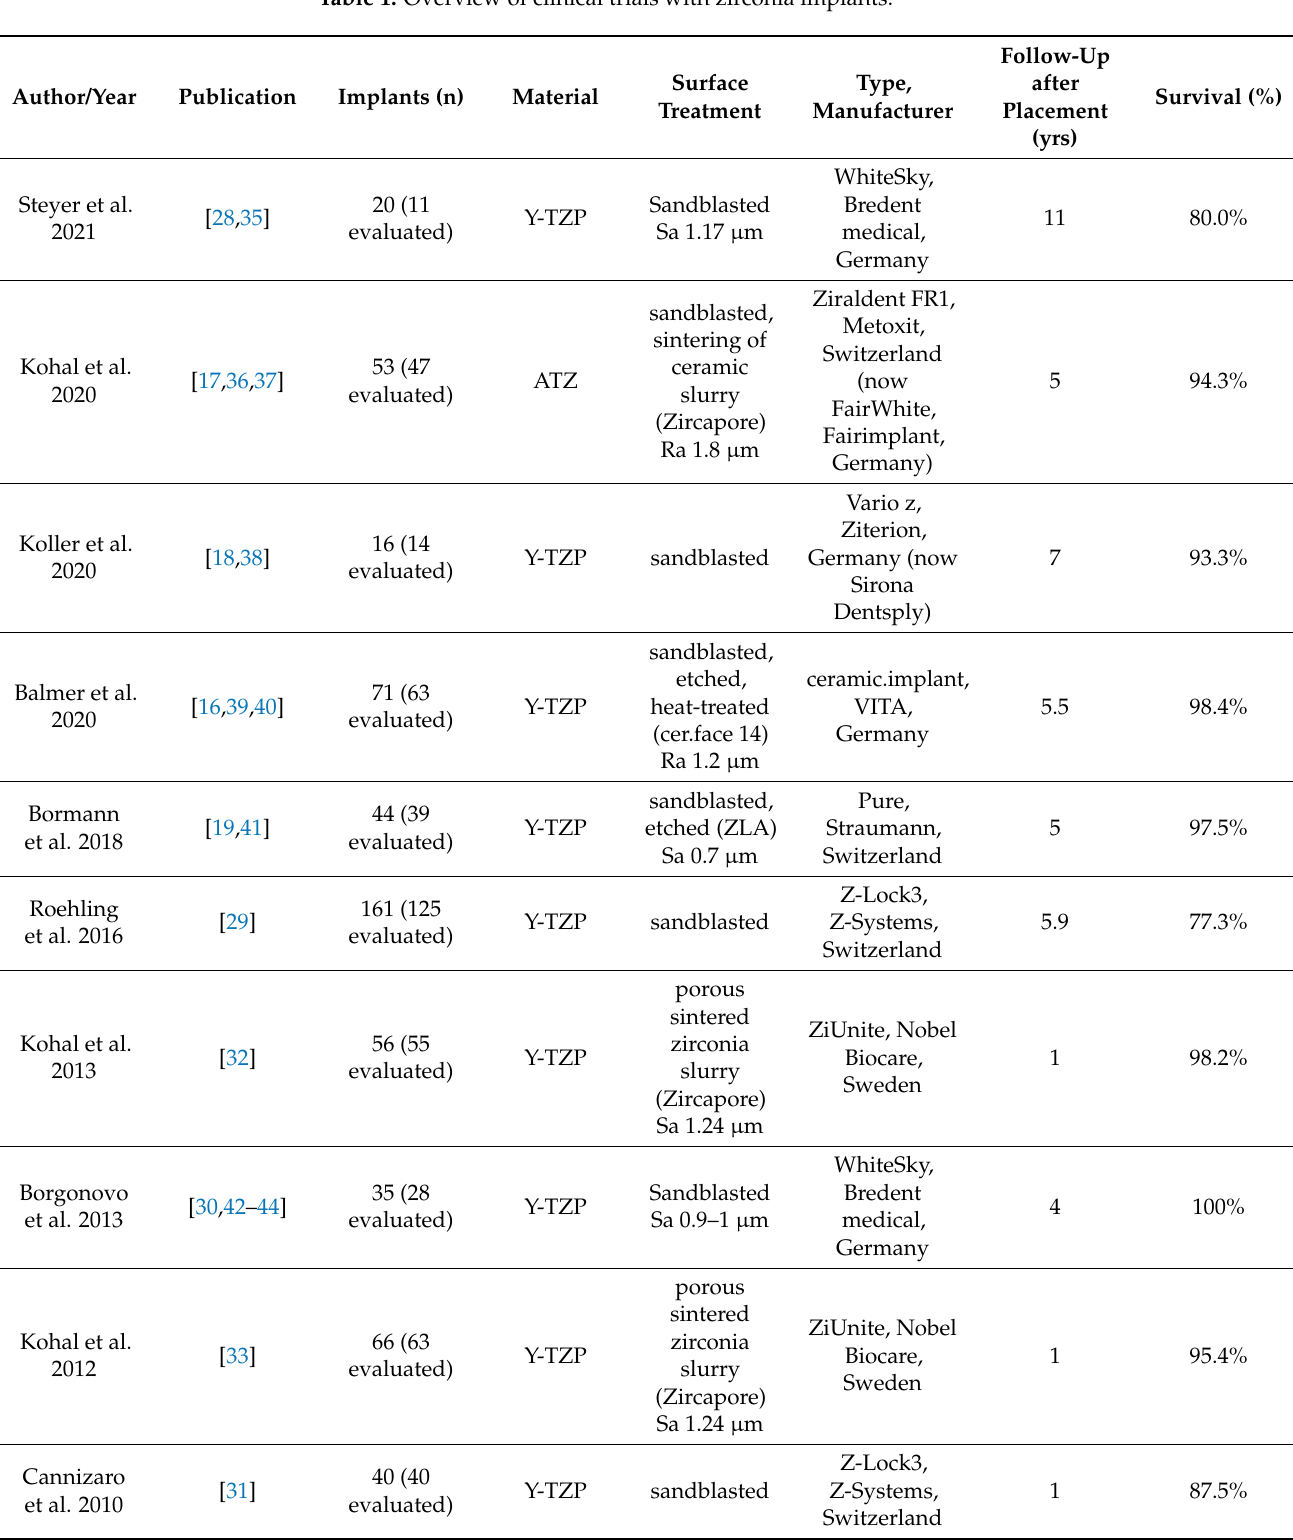
Table 1. Overview of clinical trials with zirconia